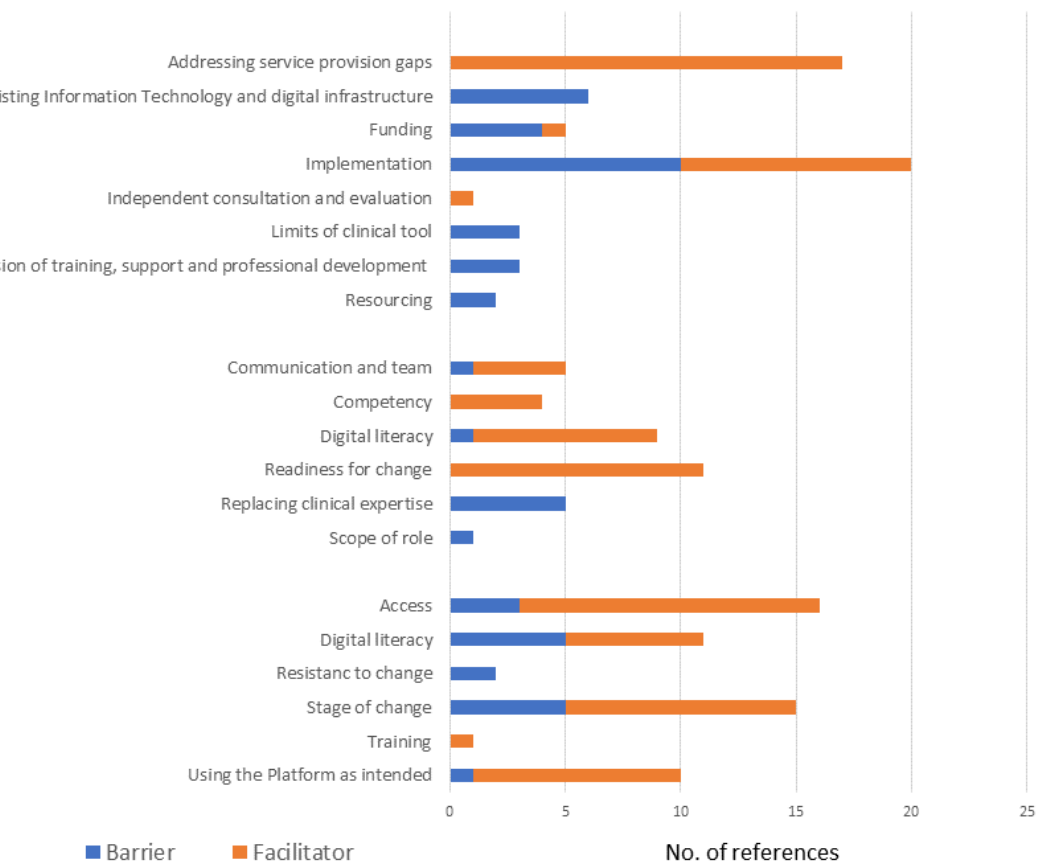
Figure 1. Codes and